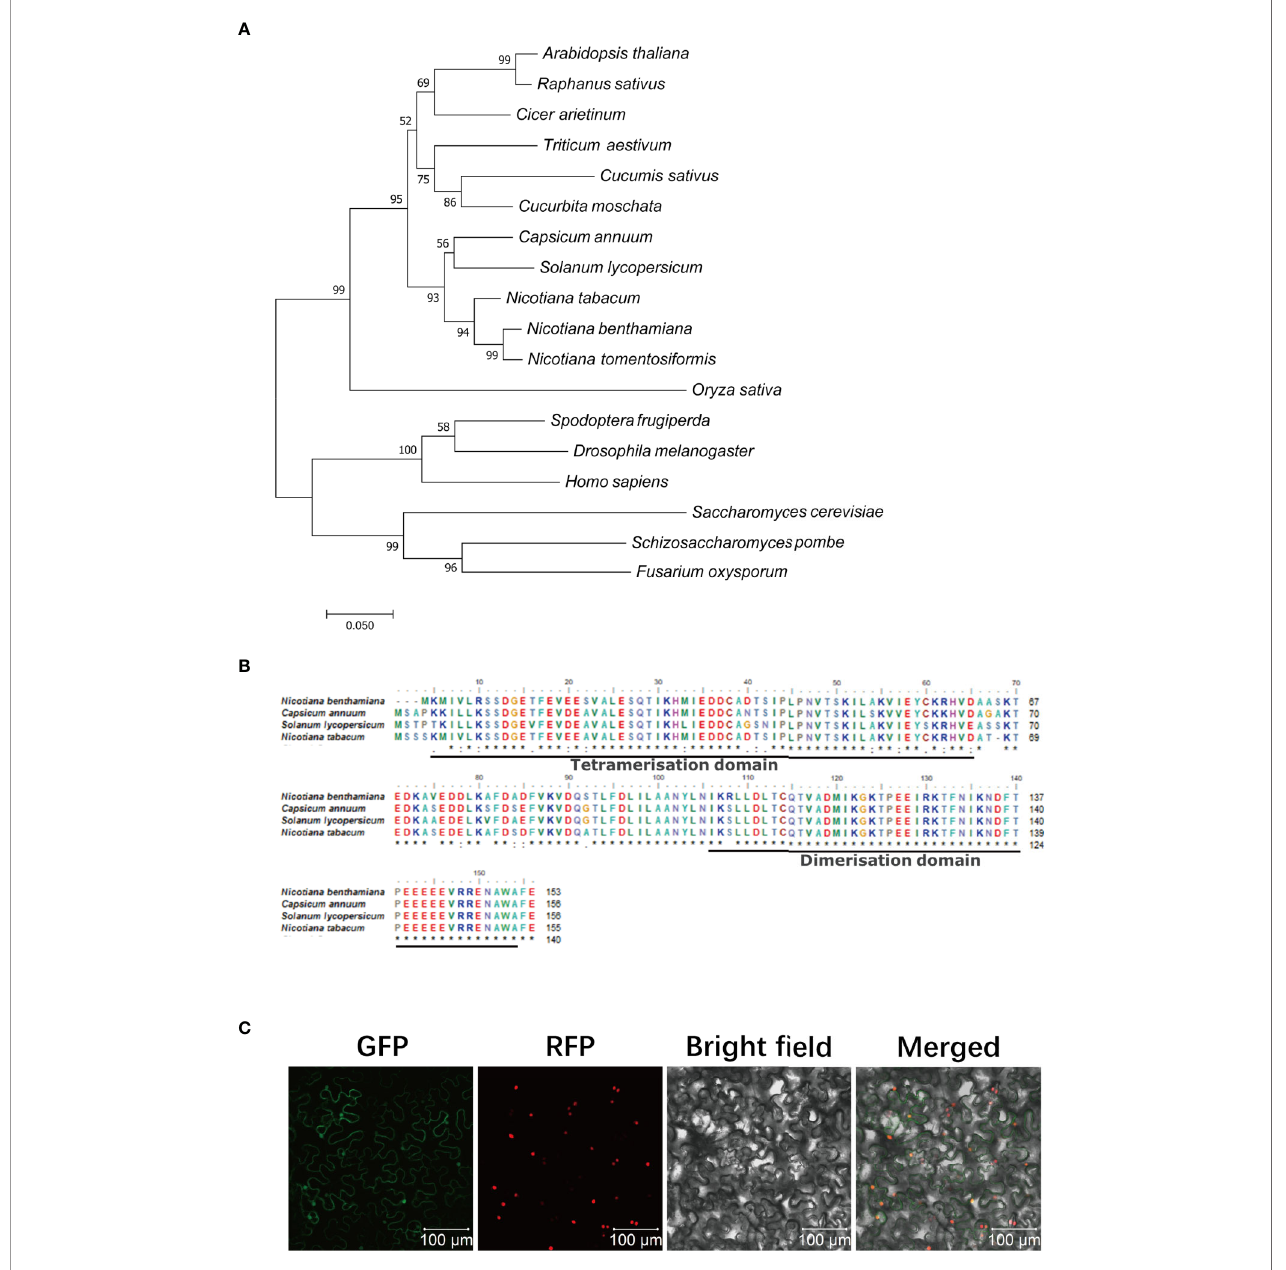
FIGURE 2 | Phylogenetic analysis, sequence comparison, and subcellular localization of NtSKP1. (A) Phylogenetic tree analysis of SKP1. Accession numbers of the amino acid sequences included in the phylogenic tree as following as: Nicotiana benthamiana (AAO85510.1); common tobacco Nicotiana tabacum (XP_016435415.1); tobacco Nicotiana tomentosiformis (XP_009620406.1); radish Raphanus sativus (XP_018446355.1); chilly Capsicum annuum (AAX83944.1); tomato Solanum lycopersicum (ALA48968.1); Arabidopsis thaliana (NP_565123.1); wheat Triticum aestivum (AIJ50267.1); cucumber Cucumis sativus (XP_004146156.1); squash Cucurbita moschata (XP_022923340.1); Cicer arietinum (NP_001352203.1); rice Oryza sativa (AAT09201.1); fall armyworm Spodoptera frugiperda (AGP04177.1); fruit fl y Drosophila melanogaster (NP_001284 755.1); human Homo sapiens (NP_008861.2); brewer ’ s yeast Saccharomyces cerevisiae (NP_010615.3); fi ssion yeast Schizosaccharomyces pombe (BAB62325.1); Fusarium oxysporum (AAT85970.1). These sequences were aligned by ClustalW. Phylogenetic analysis was conducted with MEGA 7.0 through neighbor-joining (NJ) method (1,000 replications). (B) Amino acid sequence alignment and domain analysis of SKP1 proteins among Nicotiana benthamiana , Capsicum annuum , Solanum lycopersicum , and Nicotiana tabacum . (C) Subcellular localization of NtSKP1. Fusion protein NtSKP1-GFP were transiently expressed in N. benthamiana line H2B-RFP, of which nucleus were marked with RFP fusion protein. Photos were imaged at 48 h using a Zeiss LSM710 confocal microscope. Columns from left to right represent GFP fl uorescence, RFP fl uorescence, bright fi eld, and GFP/RFP/ bright fi eld overlay. Scale bars 100 m